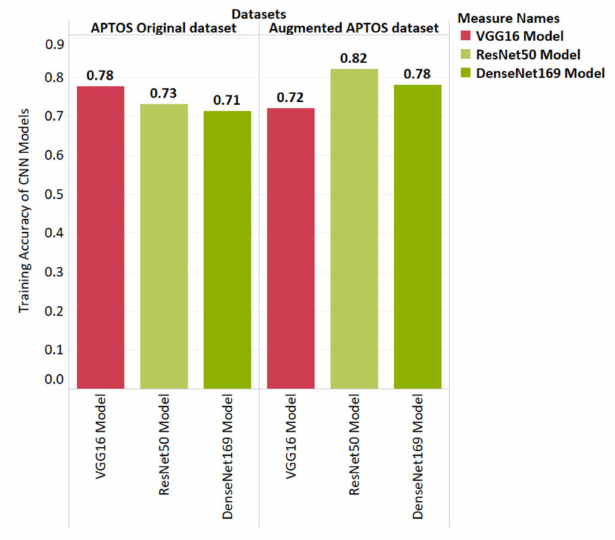
Figure 10. Testing accuracy of the CNN models for the APTOS